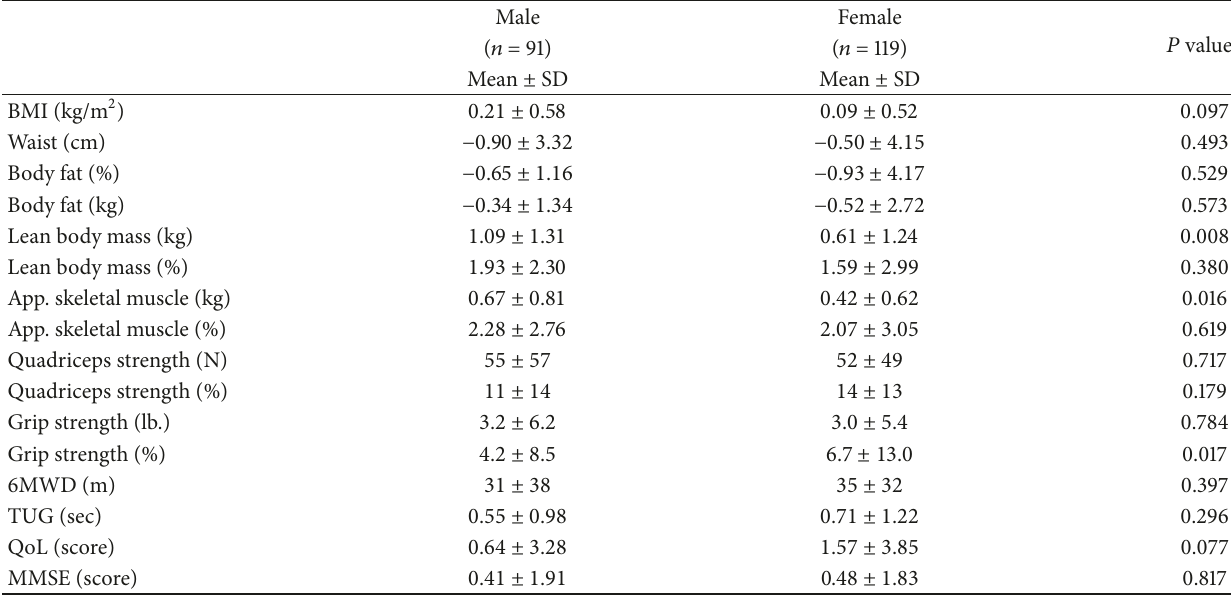
Table 3: Changes in anthropometric, physical, and functional outcomes in male and female participants after the 12-week